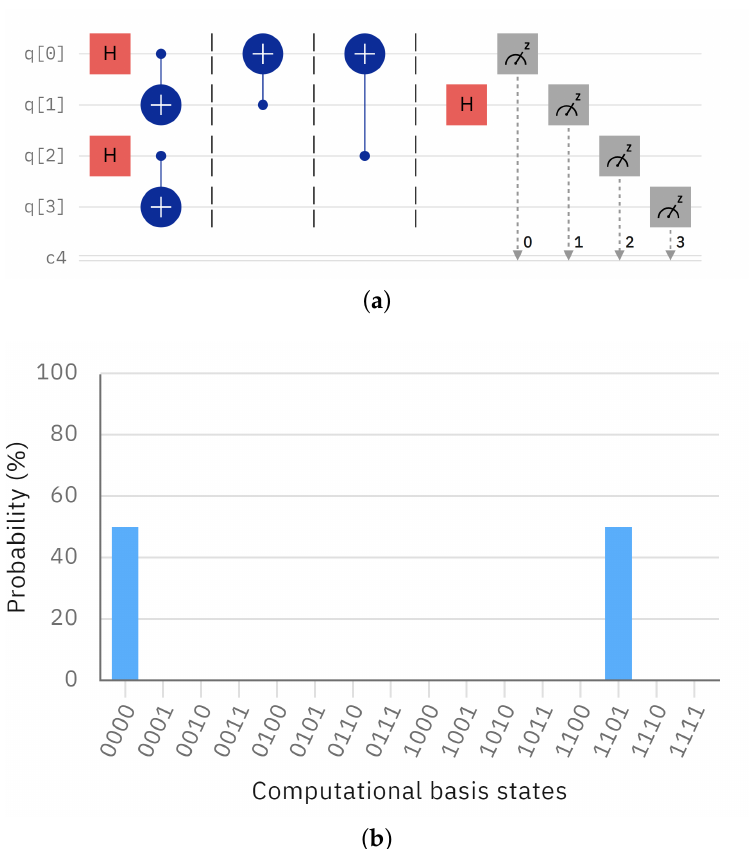
Figure 2. Generating GHZ states through 2-step multi-coin quantum walk: ( a ) Quantum circuit generating GHZ states and ( b ) simulation results. CNOT gates are indicated by blue circles in the